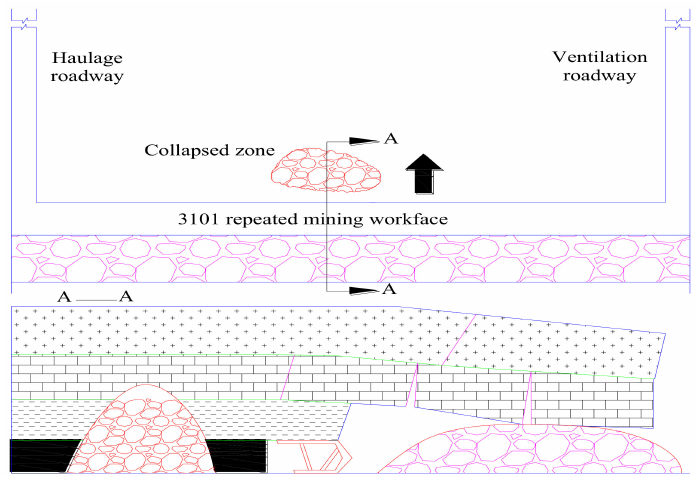
Figure 11. 3101 repeated mining working